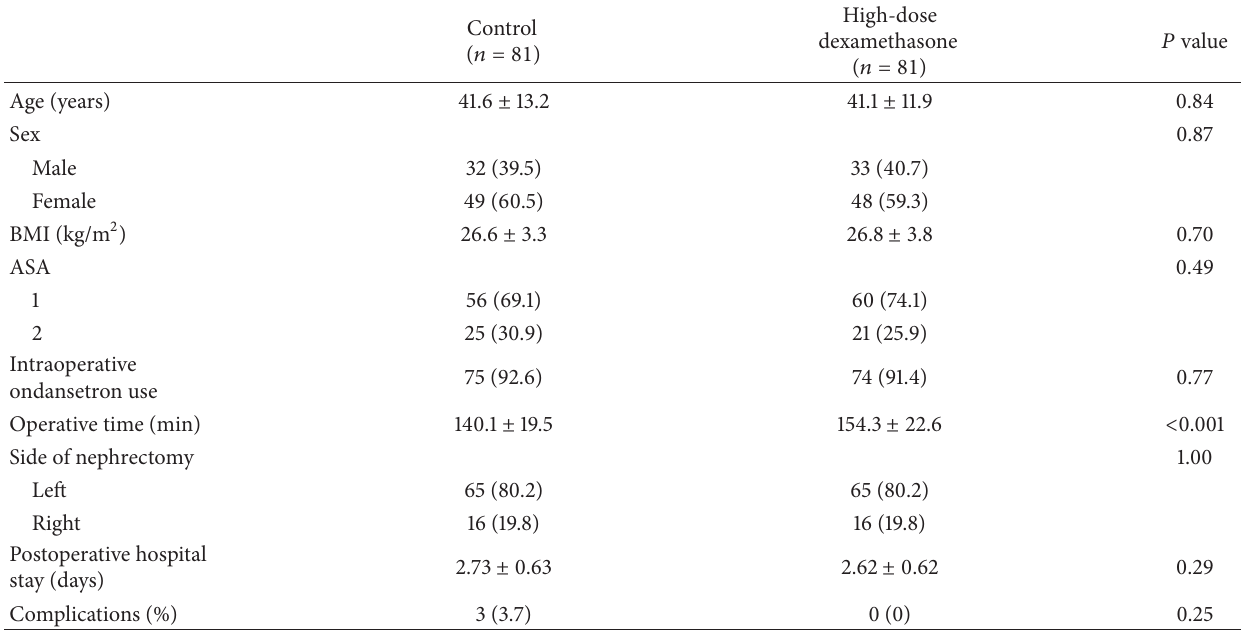
Table 3: Donor baseline variables and surgical outcomes in propensity-score matched